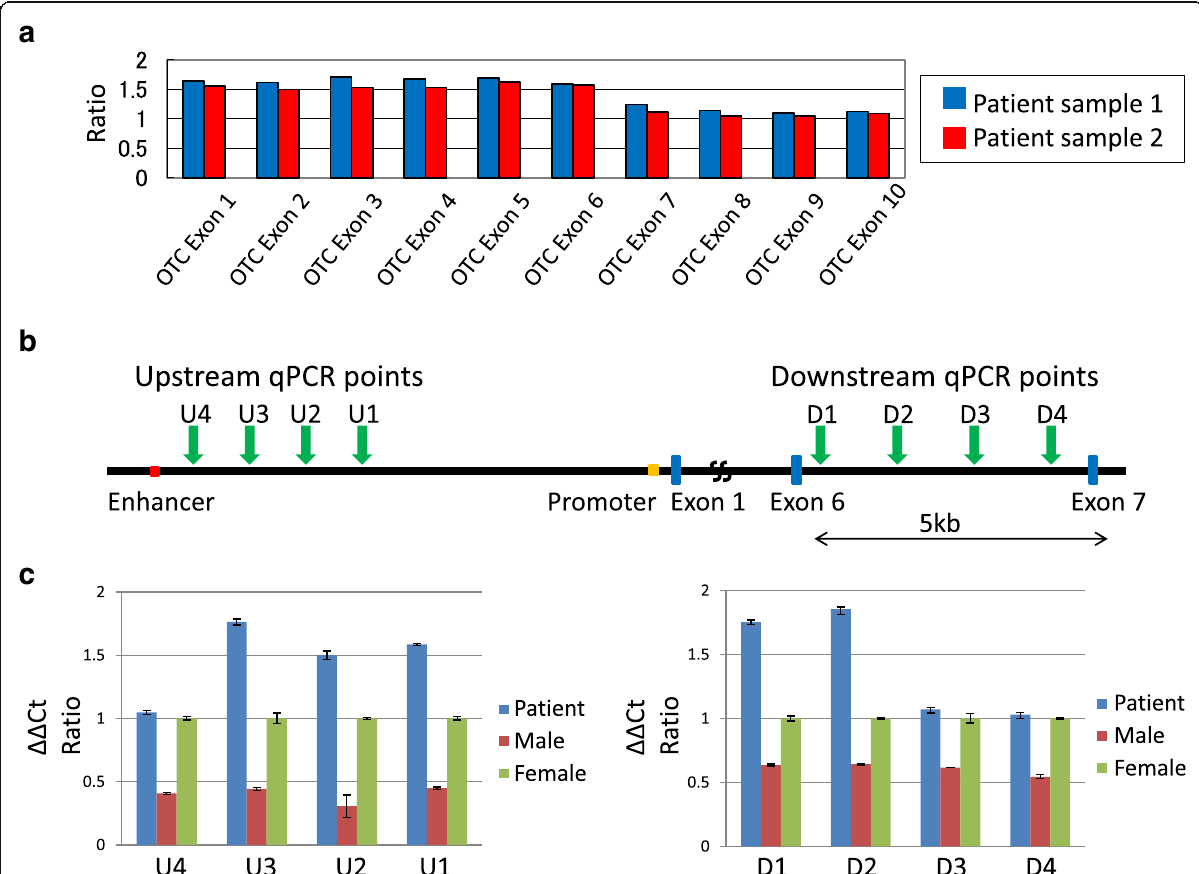
Fig. 1 Exonic duplication of the OTC gene in a female OTCD patient. a MLPA results for the OTC gene in this patient indicting duplication of exons 1 – 6. b Structure of the OTC gene. The blue boxes denote exons. The enhancer and promoter regions are shown in red and orange, respectively. The positions of the qPCR units are indicated by green arrows. Upstream qPCR units: U1 - U4. Downstream qPCR units: D1 - D4. c qPCR results. The left and right panels show the qPCR findings for the upstream and downstream regions, respectively. The blue bars indicate the patient and the red and green bars denote the male and female controls, respectively. The Y- axis indicates the ΔΔ Ct